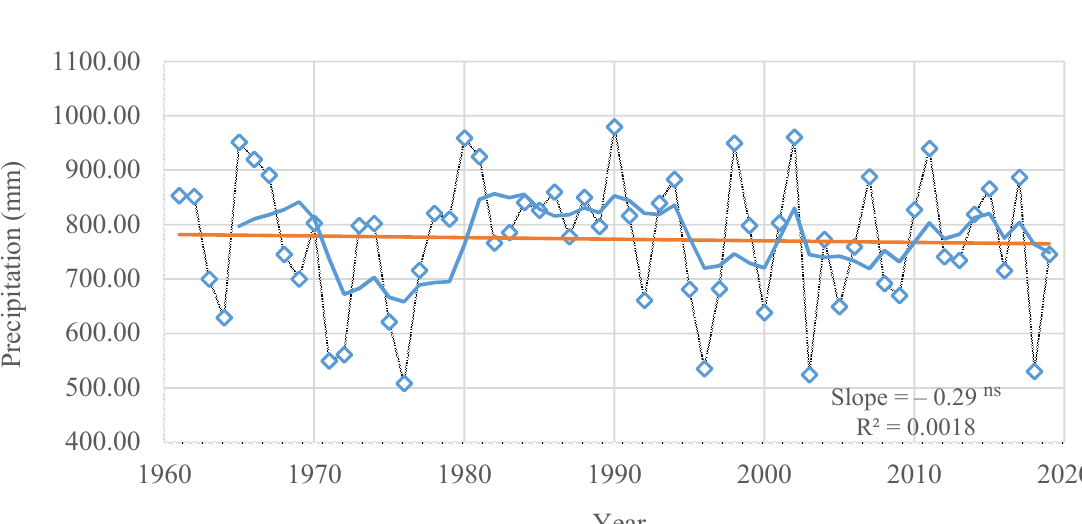
Slope = 0.0289*** R² = 0.35